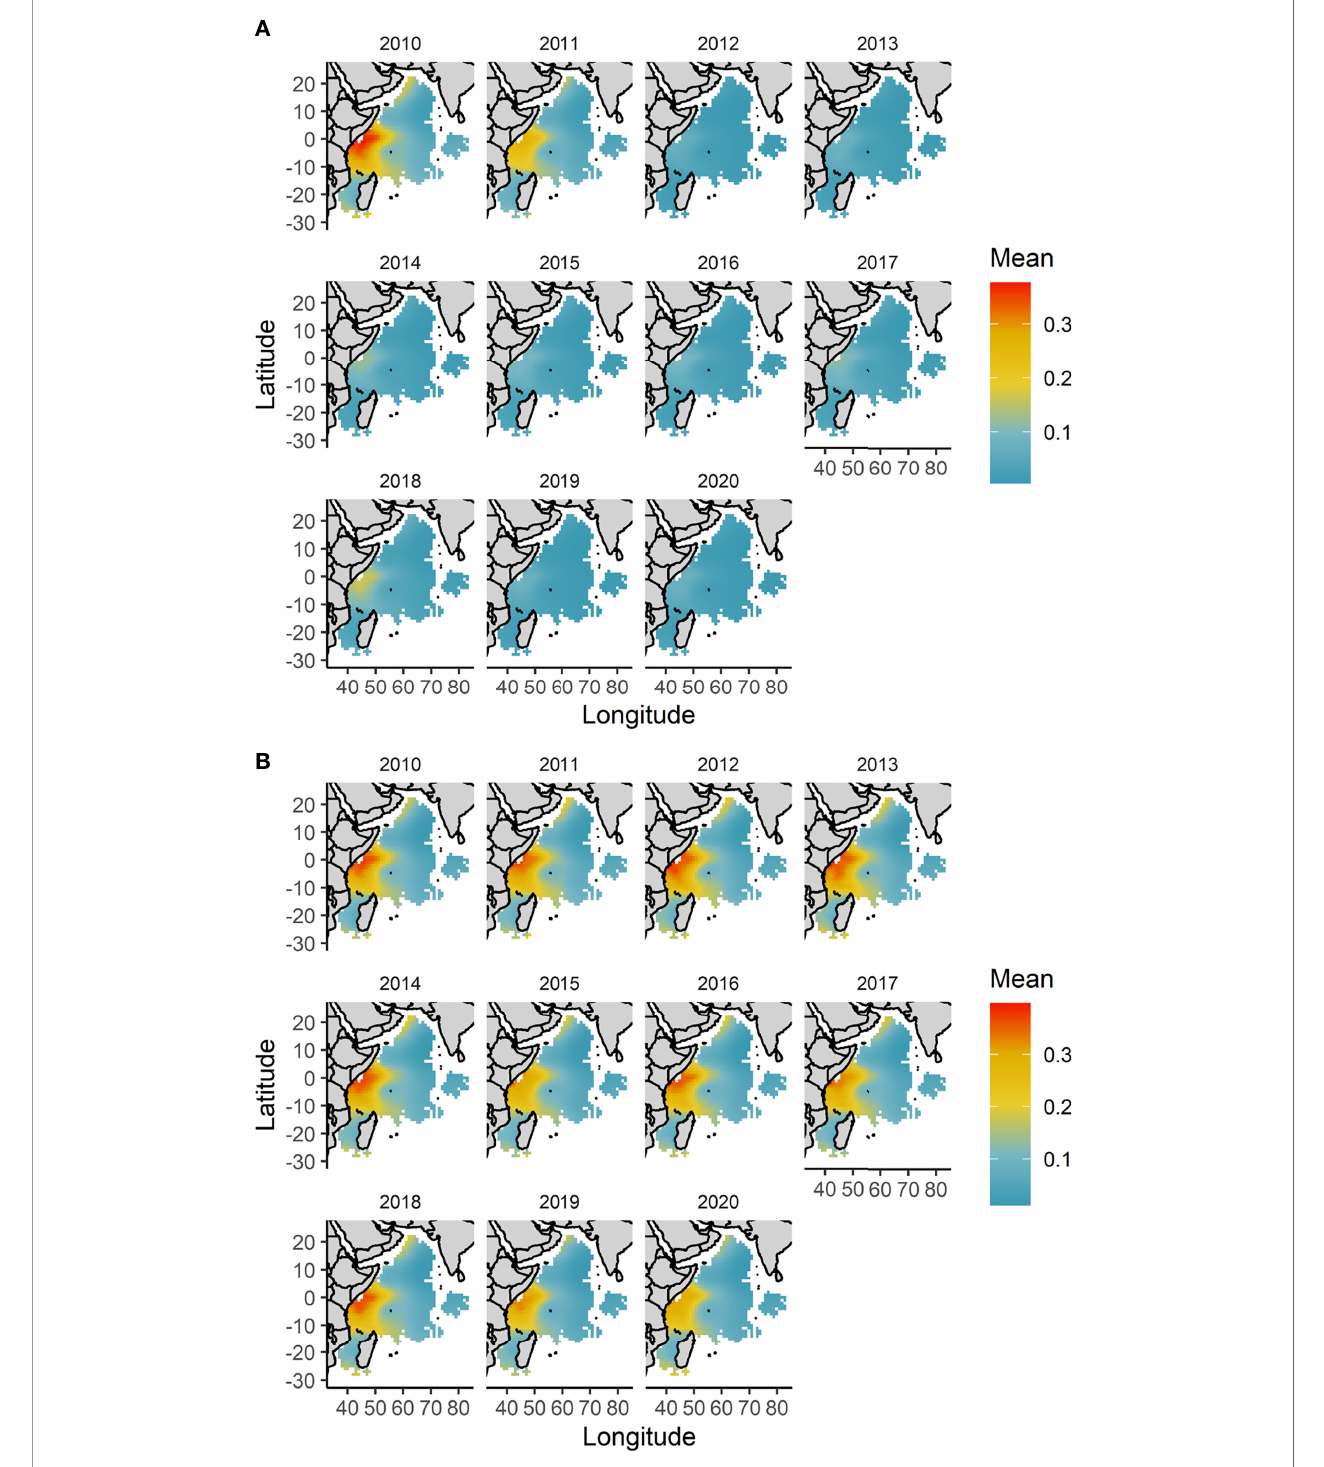
FIGURE 8 | Spatial distribution of the yearly mean predicted catch probability of an oceanic whitetip shark between 2010-2020 and across the fi shing grounds of the tropical tuna purse seine fi shery in the western Indian Ocean. (A) Model predictions account for both the year effect and changing environmental conditions. (B) Model predictions are made fi xing the year 2010 as baseline and only allowing the environmental variables of sea surface temperature and nitrogen concentration to change interannually. For predictions the FAD fi shing technique was used as